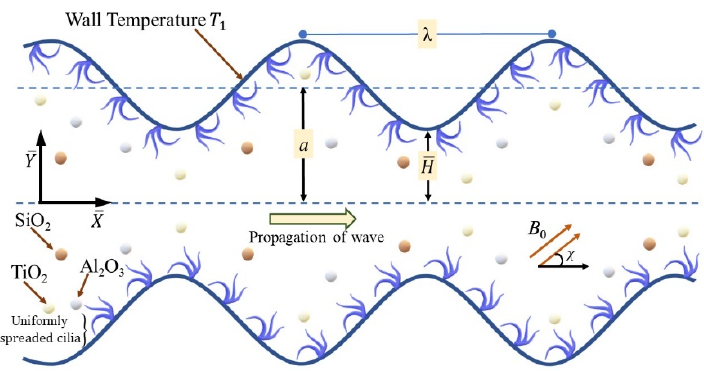
Figure 1. Geometrical model for cilia actuated flow of trihybrid nanofluid.